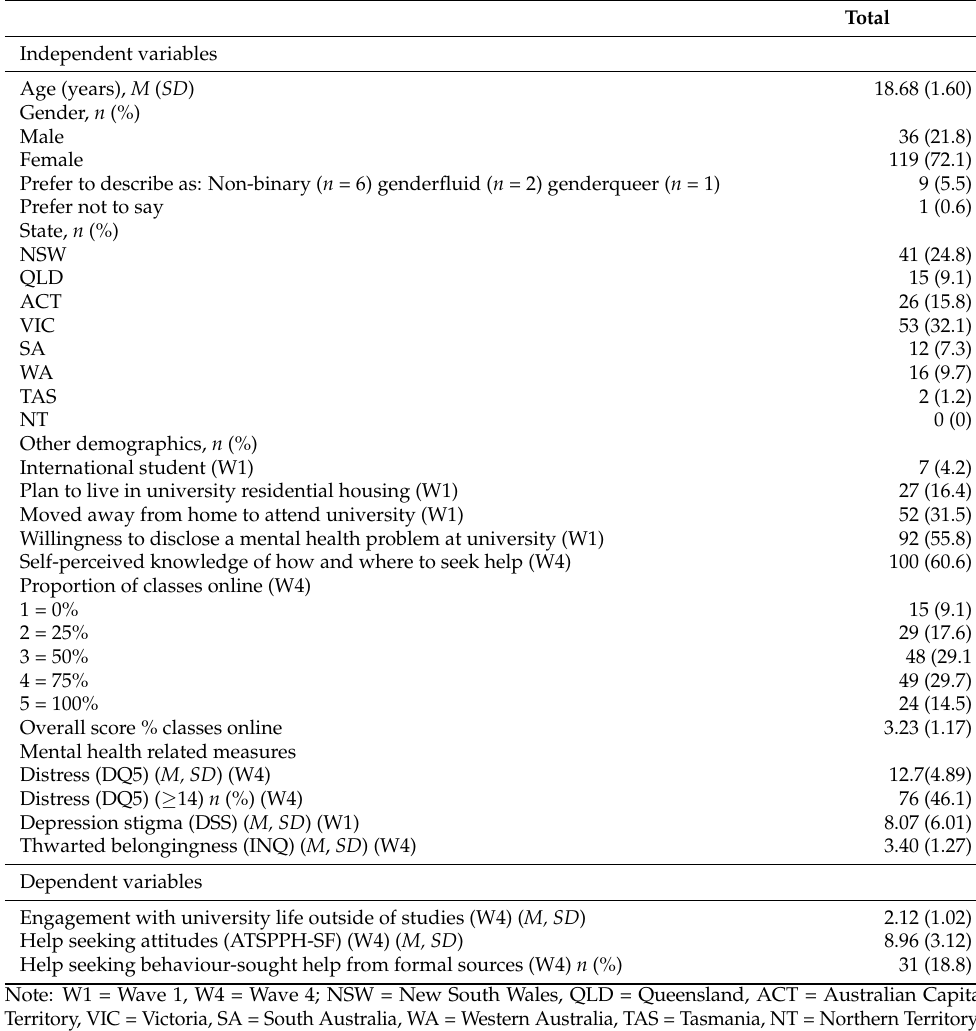
Table 1. Sample demographic information ( N =